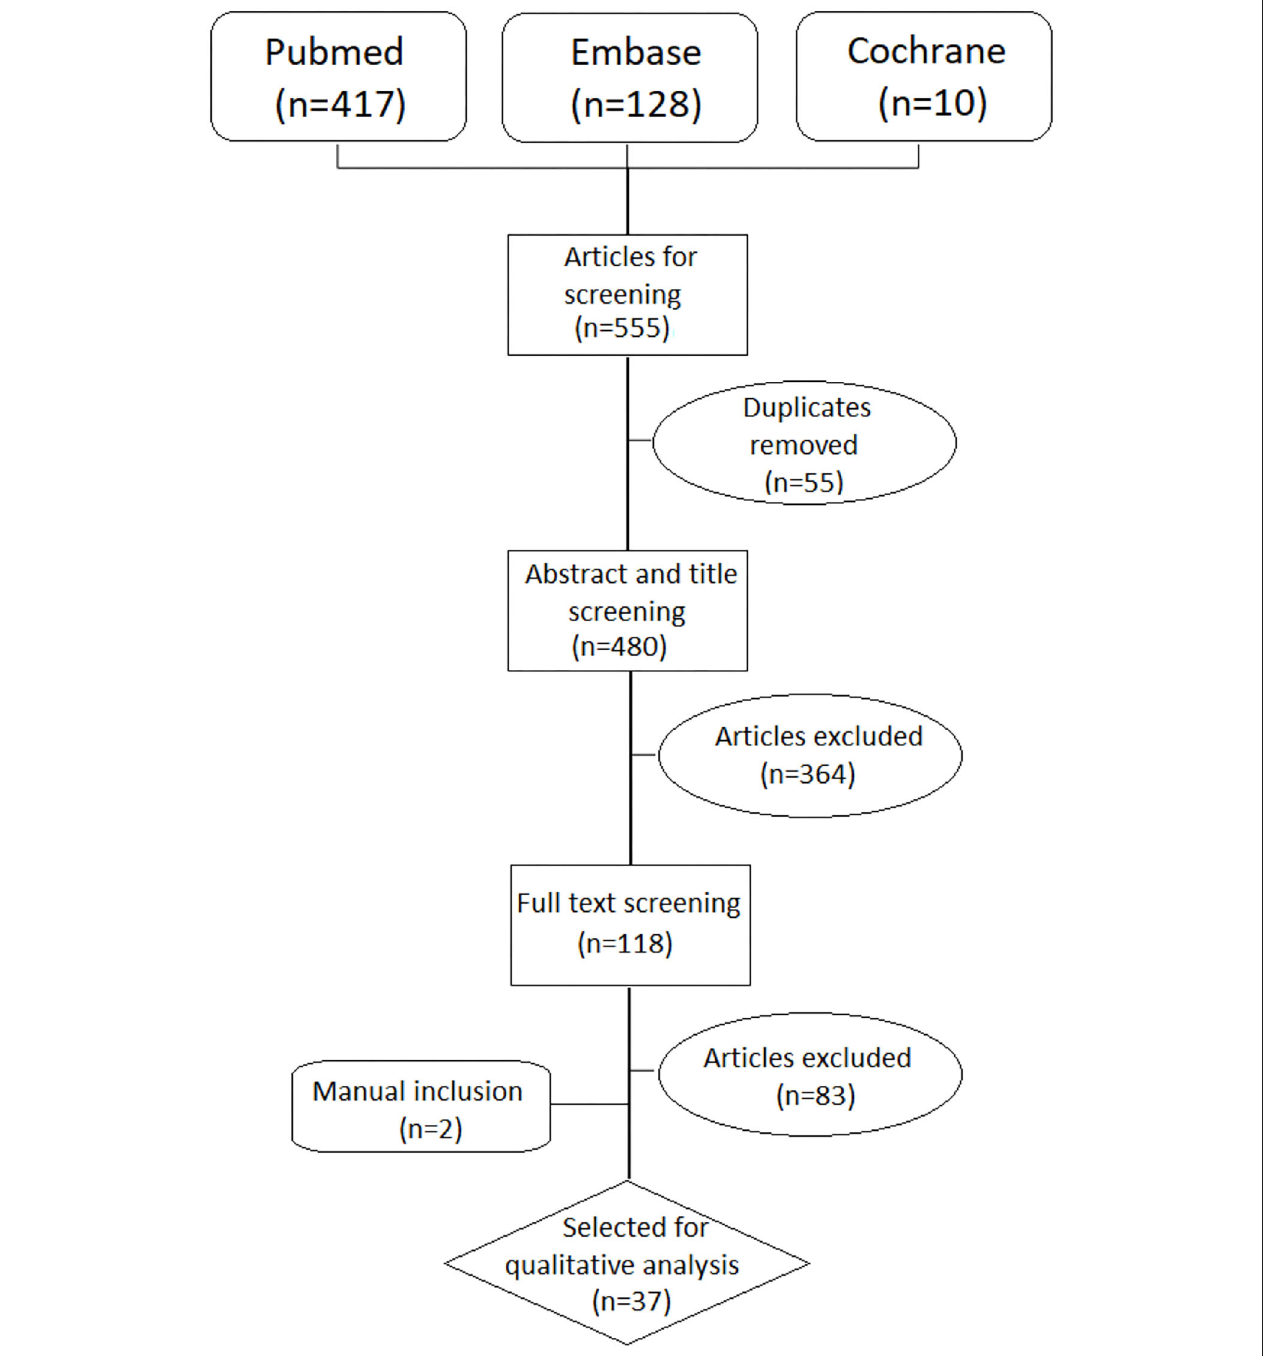
FIGURE 1 | PRISMA flow